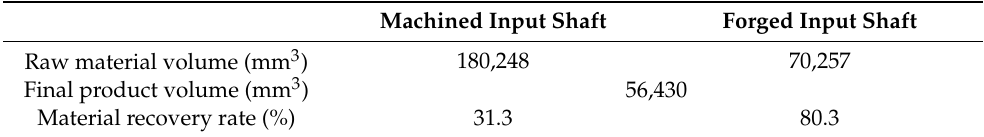
Figure 7. View of the ( a ) surface of the product, ( b ) interior of the product, and ( c ) metal flow of the produced product. Table 5. Comparison of material recovery rate between the processes.